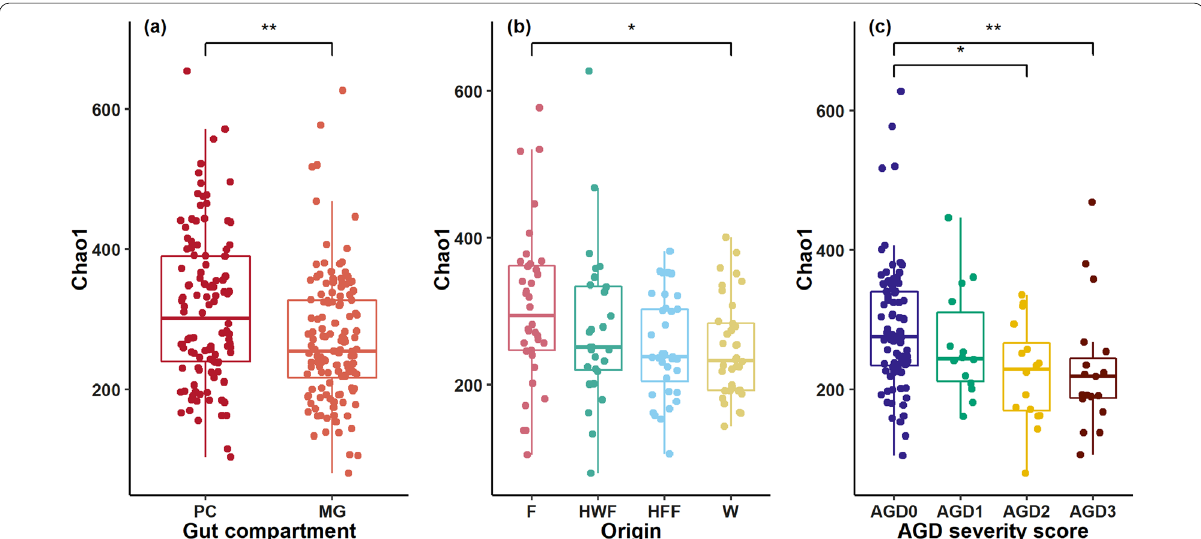
Fig. 6 Chao1 richness estimates for multiple comparisons for starved fish between gut compartments ( a ), genetic background in MG samples ( b ) and AGD severity in MG samples ( c ). Lower microbial richness in MG samples compared to PC samples. In MG samples wild fish show a lower microbial richness than farmed fish. Fish with an AGD severity score of 2 and 3 showed a lower microbial richness than non-symptomatic fish (AGD 0). PC Pyloric caeca, MG Midgut, F Farmed, HWF Hybrid Wild Female, HFF Hybrid Farmed Female, W Wild. Significance was determined = = = = = = by Dunn’s test for multiple comparisons of groups of significant Kruskal–Wallis results. Significance codes shown for significant differences: ** p < 0.01; * p < 0.05